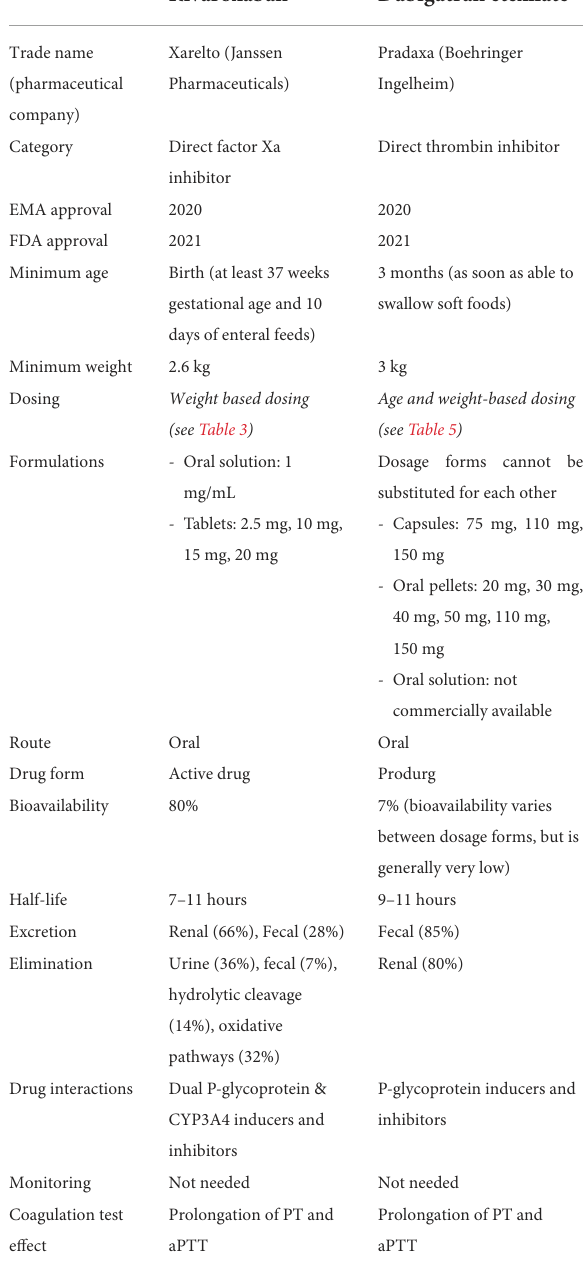
TABLE 1 DOAC characteristics, pharmacodynamics, and pharmacokinetics.